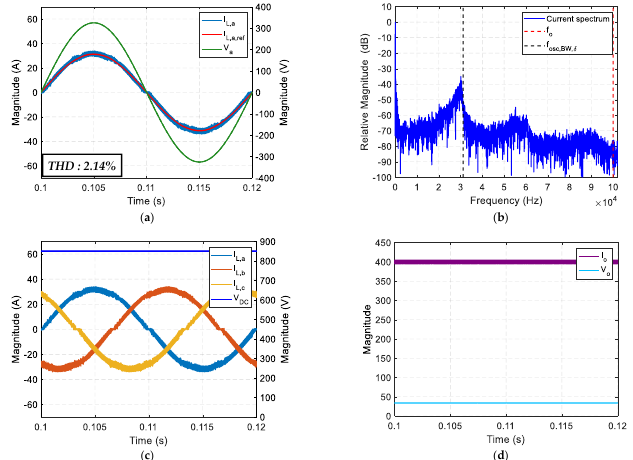
Figure 14. Waveforms of the global energy conversion chain: ( a ) grid voltage, grid current controlled by DPSSOCC and its reference, ( b ) current spectrum of the phase a, ( c ) input currents and DC voltage bus and ( d ) arc current and voltage.